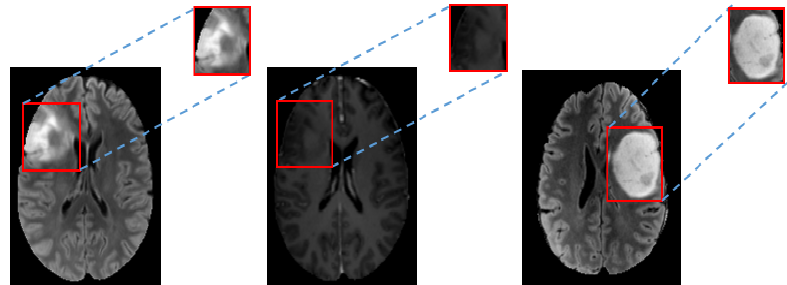
Figure 5. Example of allocated tumor regions by rectangular bounding boxes for tumor feature learning. Left to Right: FLAIR, T1ce and